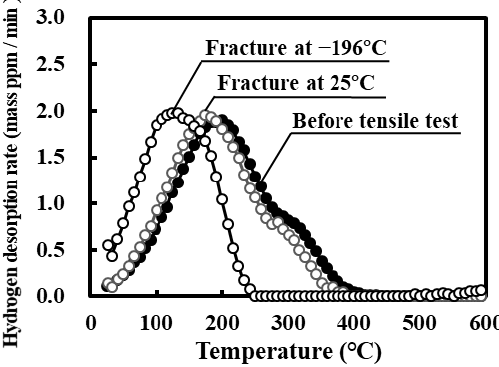
Figure 6. Hydrogen thermal desorption curves for specimens subjected to tensile fracture at 25 °C or −196 °C after modified hydrogen charging. The curve for the specimen before the tensile test is reproduced from Figure 4.